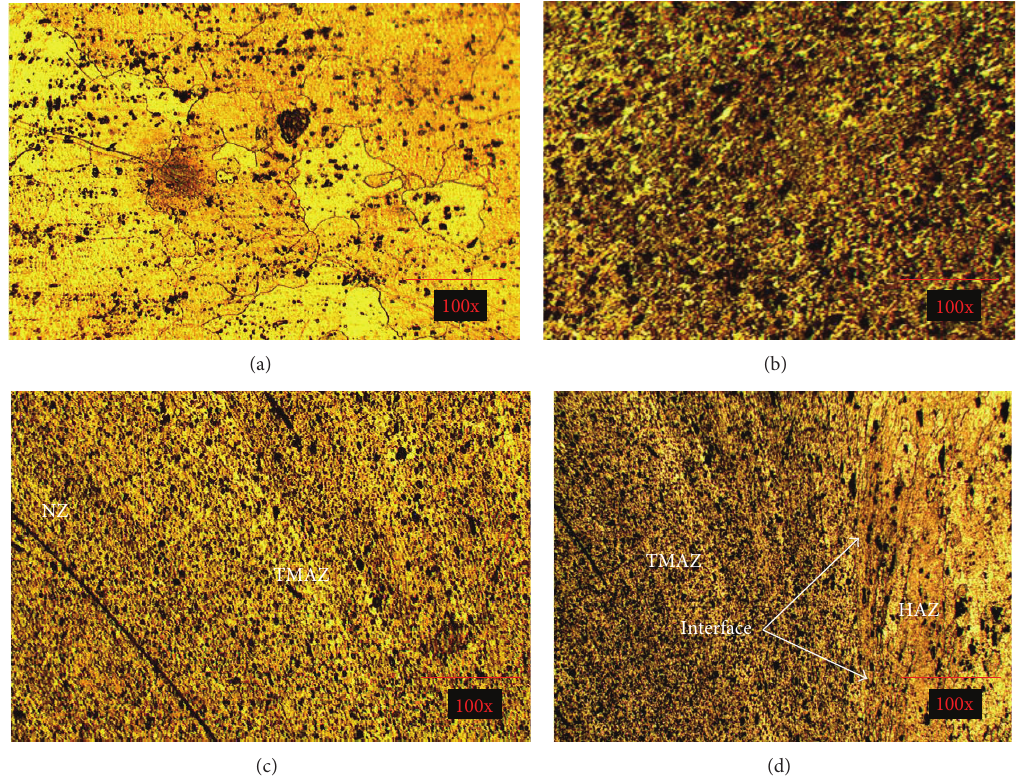
Figure 10: Optical images reveal the microstructures of different welding zones on Al-Al butt welded joint performed by FSW at a rotational speed of 2720 rpm. (a) BM, (b) NZ, (c) NZ and TMAZ, and (d) TMAZ and HAZ 100x magnification.